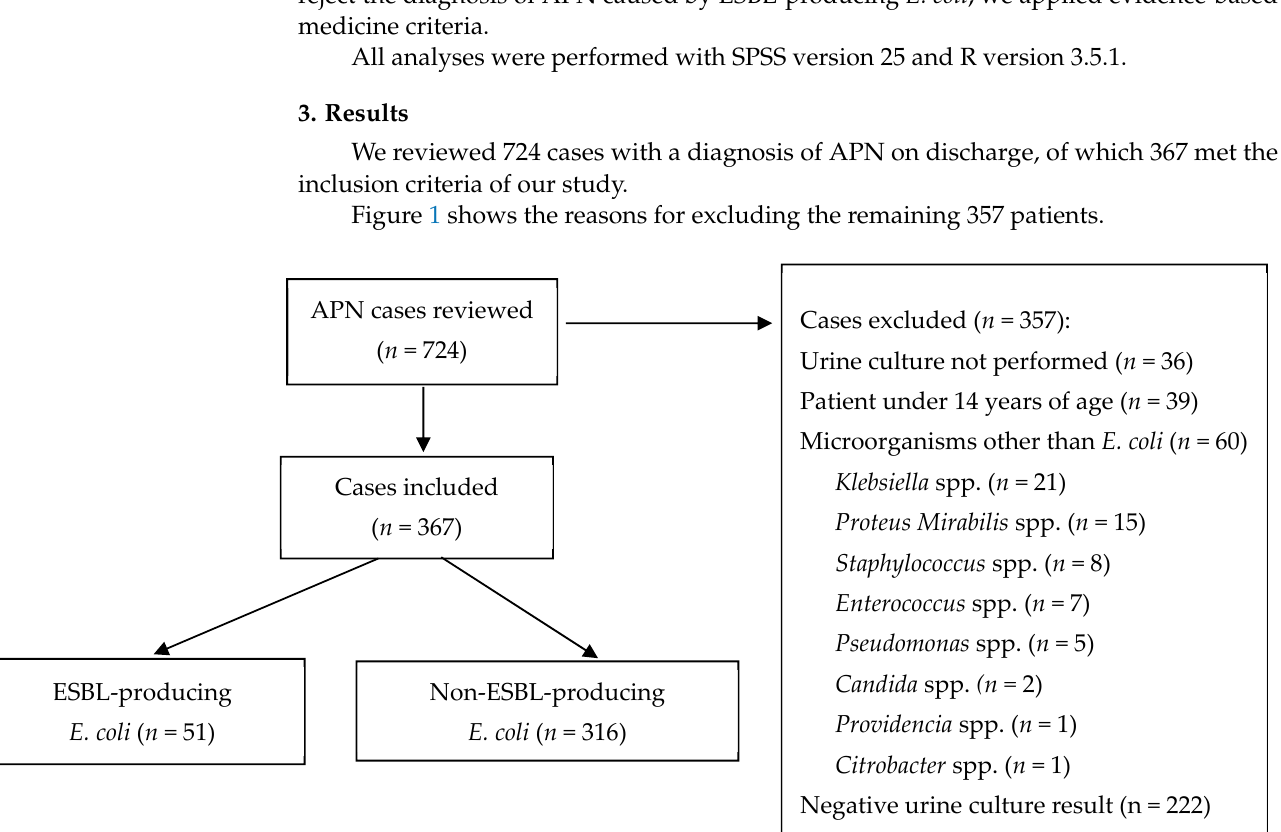
Figure 1. APN cases analysed, included, and excluded, with reasons for exclusion.